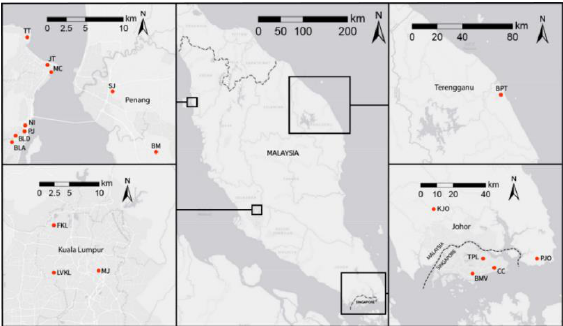
Figure 1. Sampling location of the bed bugs samples from the current study.